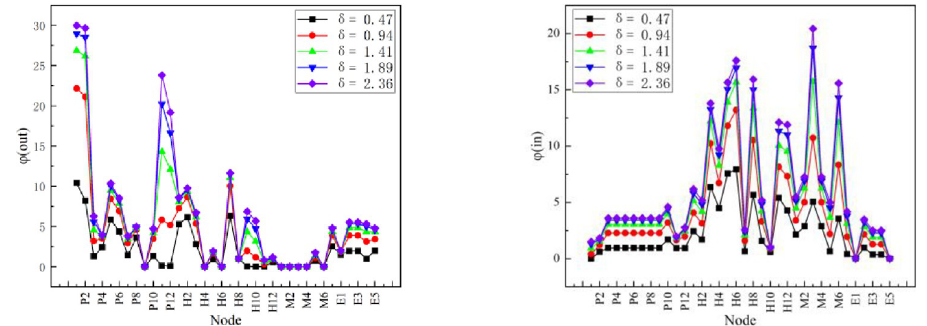
Fig 5. The out-degree and in-degree topological potentials for different influential factors.